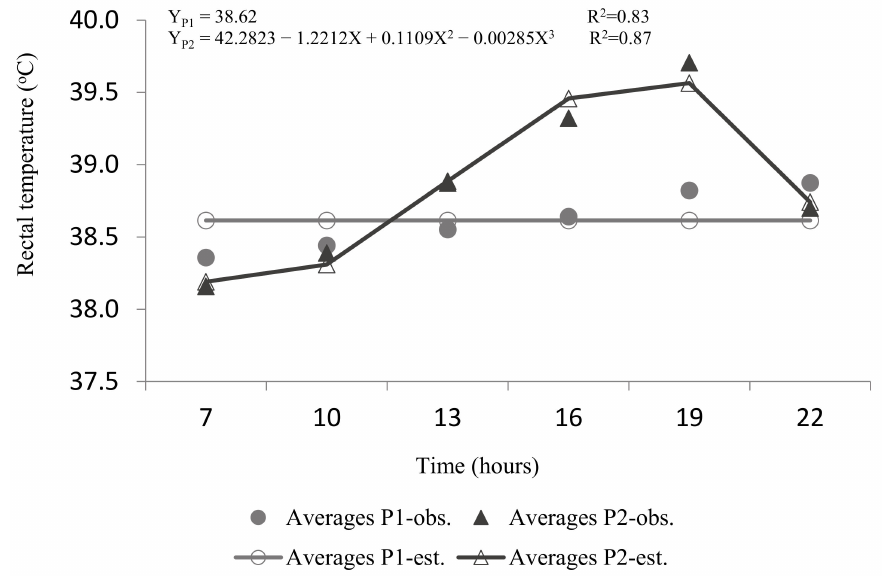
Figure 7. Regression equations between the variable RT over the hours in P1 and P2 (observed values vs. predicted